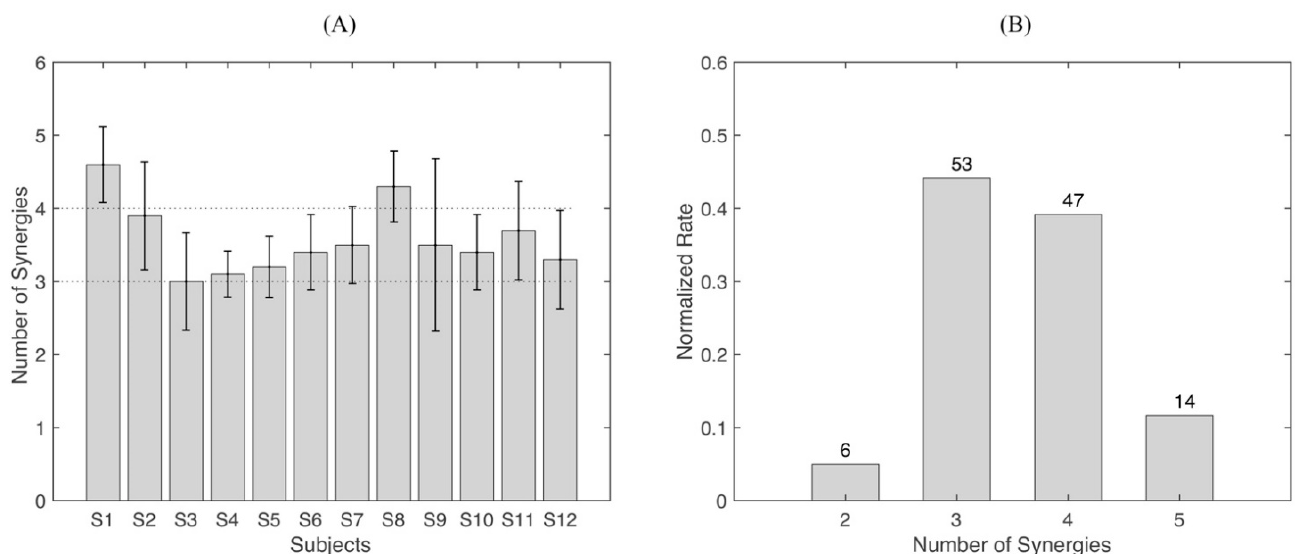
Figure 4. The number of extracted synergies. ( A ) Mean number of synergies across repetitions from each subject. Each bar indicates a subject, and the error bar is the standard deviation across repetitions. ( B ) Number of synergies and percentage from all repetitions and all subjects. In total, 120 synergy extractions were performed in this study (12 subjects, 10 repetitions each).